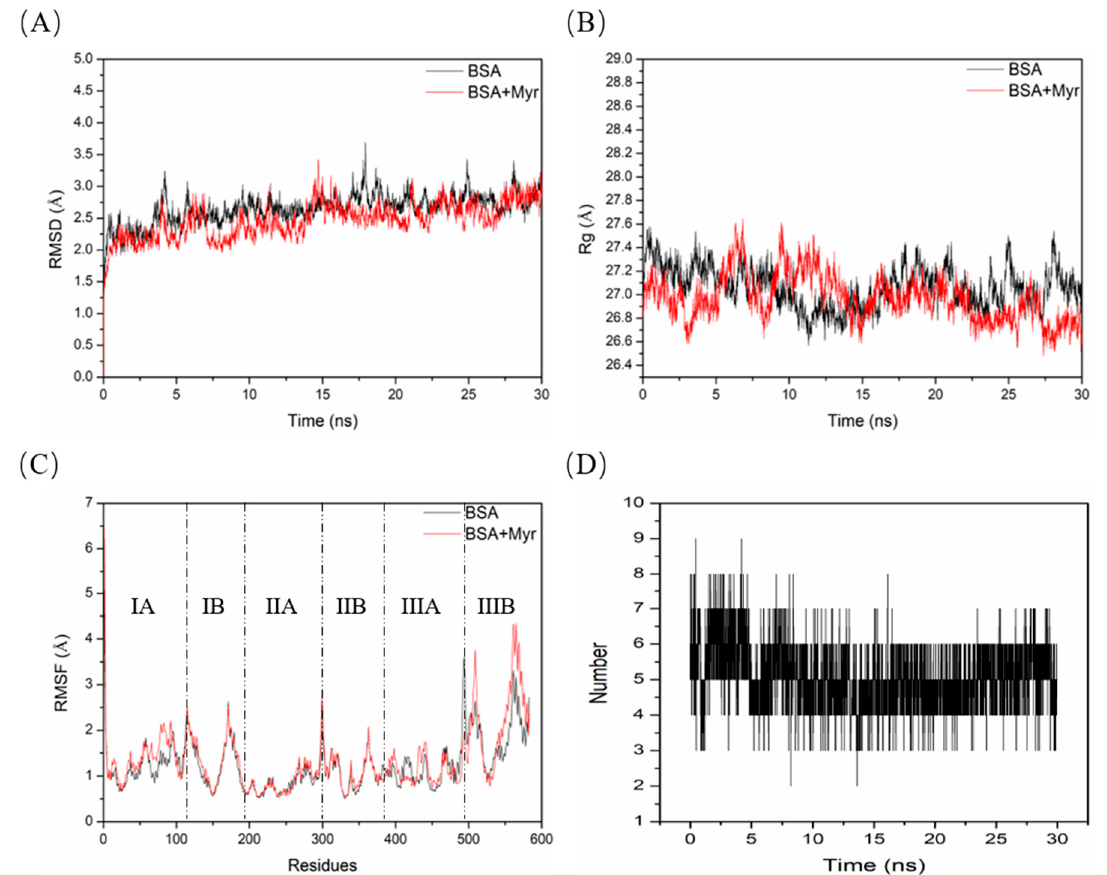
Figure 7. The results of 30 ns MD simulations. ( A – C ) represent the RMSD, Rg and RMSF values of the BSA and BSA-Myr systems, respectively. ( D ) Hydrogen bonds involved during the interaction between Myr and binding pocket residues of BSA.